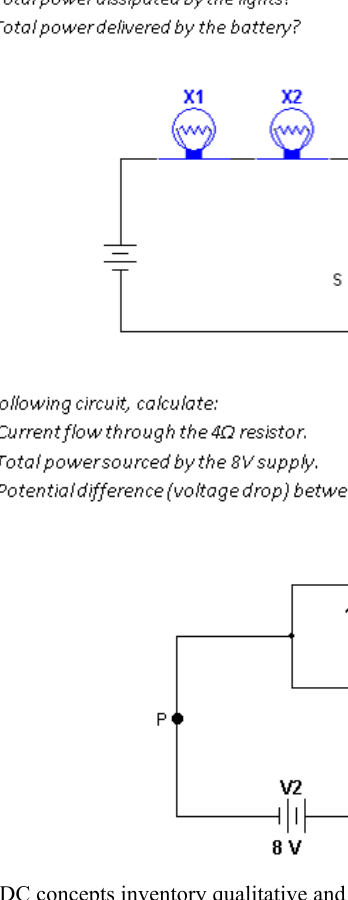
Fig. 2. DC concepts inventory qualitative and quantitative